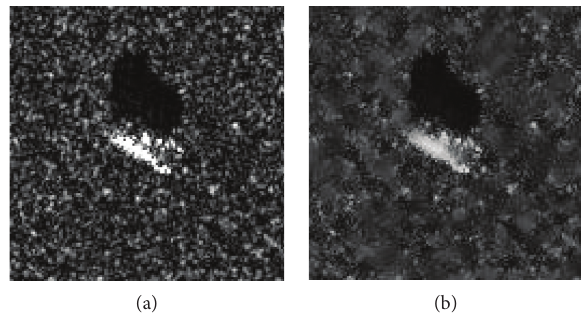
Figure 3: (a) The original image. (b) Image after lee